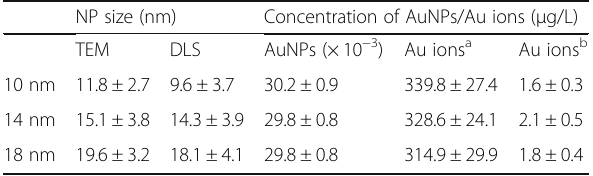
Table 1 The size and size distribution of AuNPs obtained by TEM and DLS analysis together with concentrations of AuNPs (AAS) and Au ions (ICP-MS)